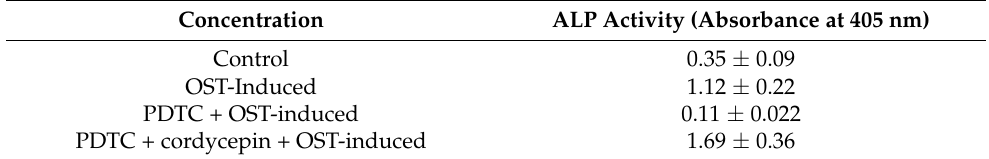
Table 7. Quantification of ALP activity—day 21.